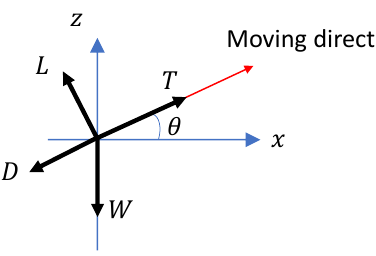
Figure 4. The forces acting on the